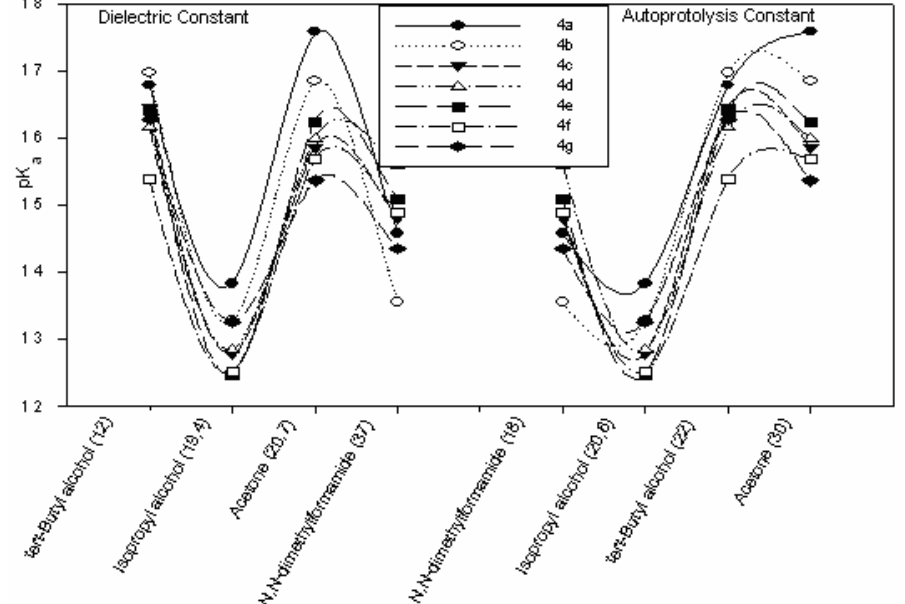
Figure 6. The variation of the pK and autoprotolysis